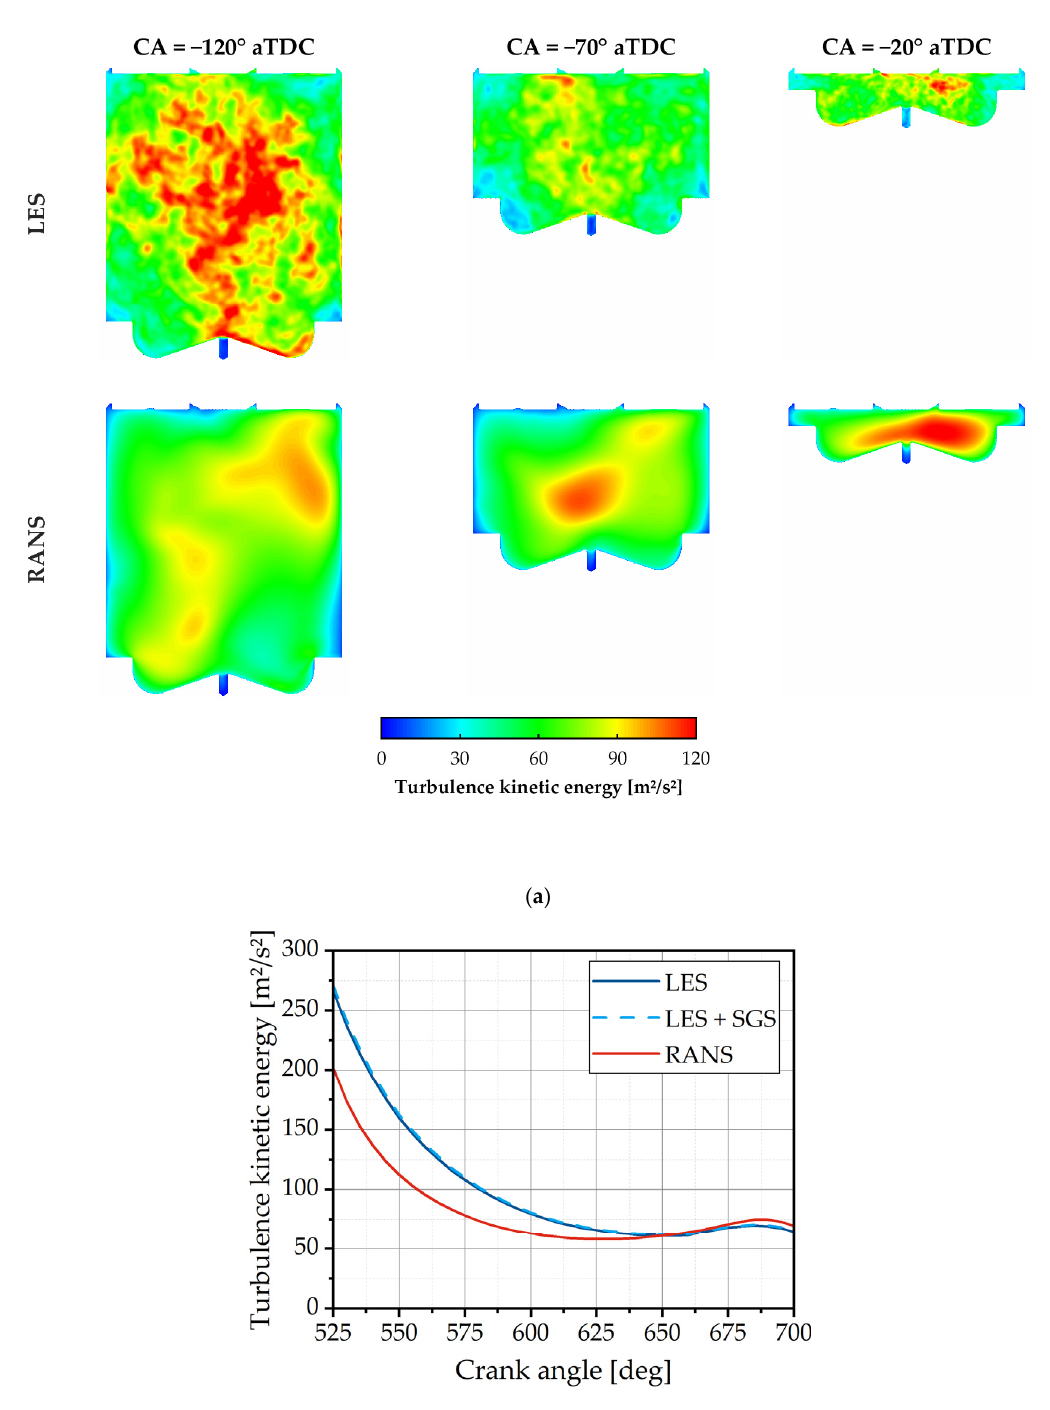
Figure 2. ( a ) Turbulent kinetic energy in the combustion chamber of a large bore dual fuel engine during compression stroke for 3 different crank angles simulated with LES (upper row), RANS (lower row); ( b ) average turbulent kinetic energy over degree crank angle for RANS and LES (with and without SGS).